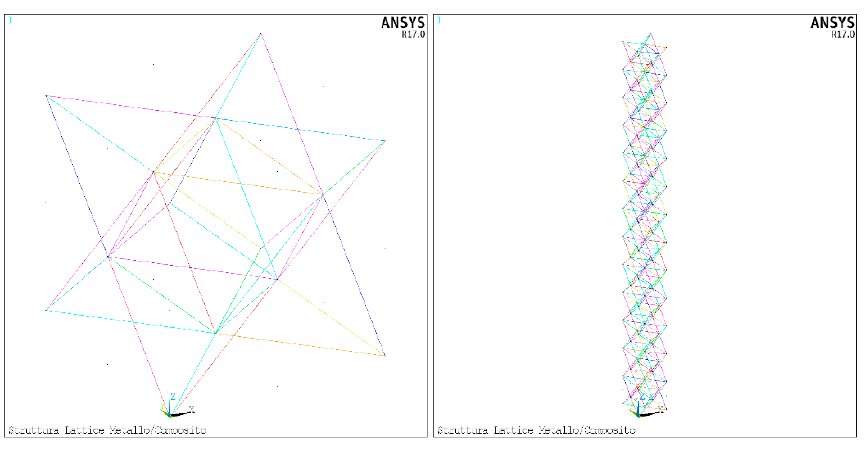
Figure 20. Test case 2—octahedral unit cell and 1st quarter.